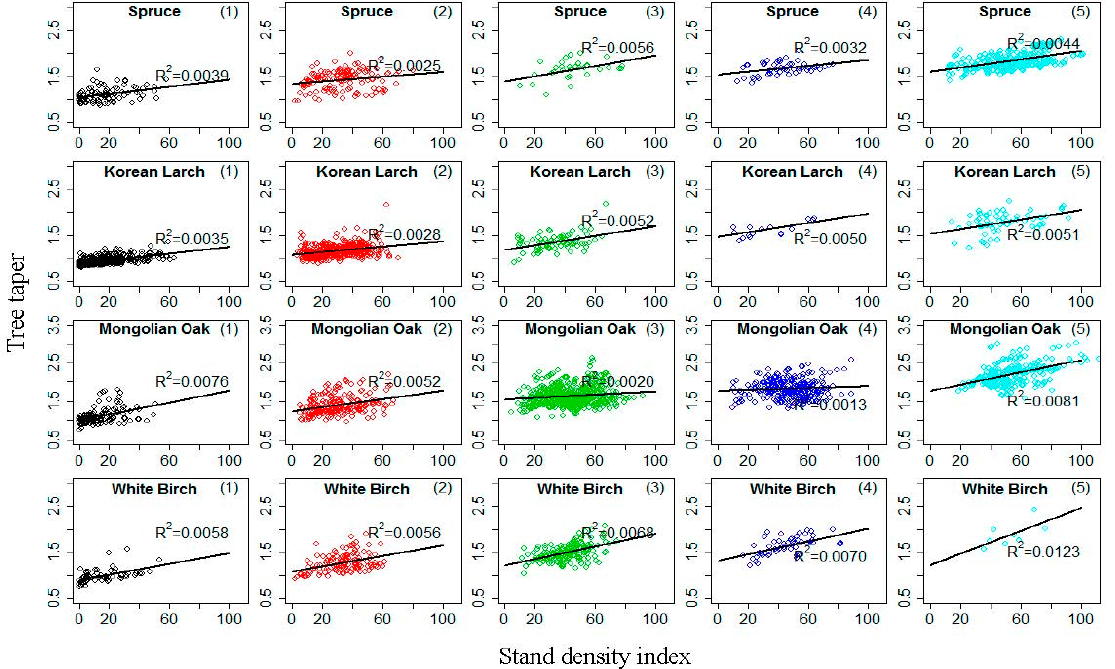
Figure 5. Scatterplot of tree taper against stand density index within five age classes (all dominant and codominant trees were stratified into the first four age classes [1–5] based on age intervals of 20 years; the fifth class was age >80 years) for four natural uneven-aged pure stands of Spruce, Korean Larch, Mongolian Oak, and White Birch; lines illustrate linear relationship between the two variables.